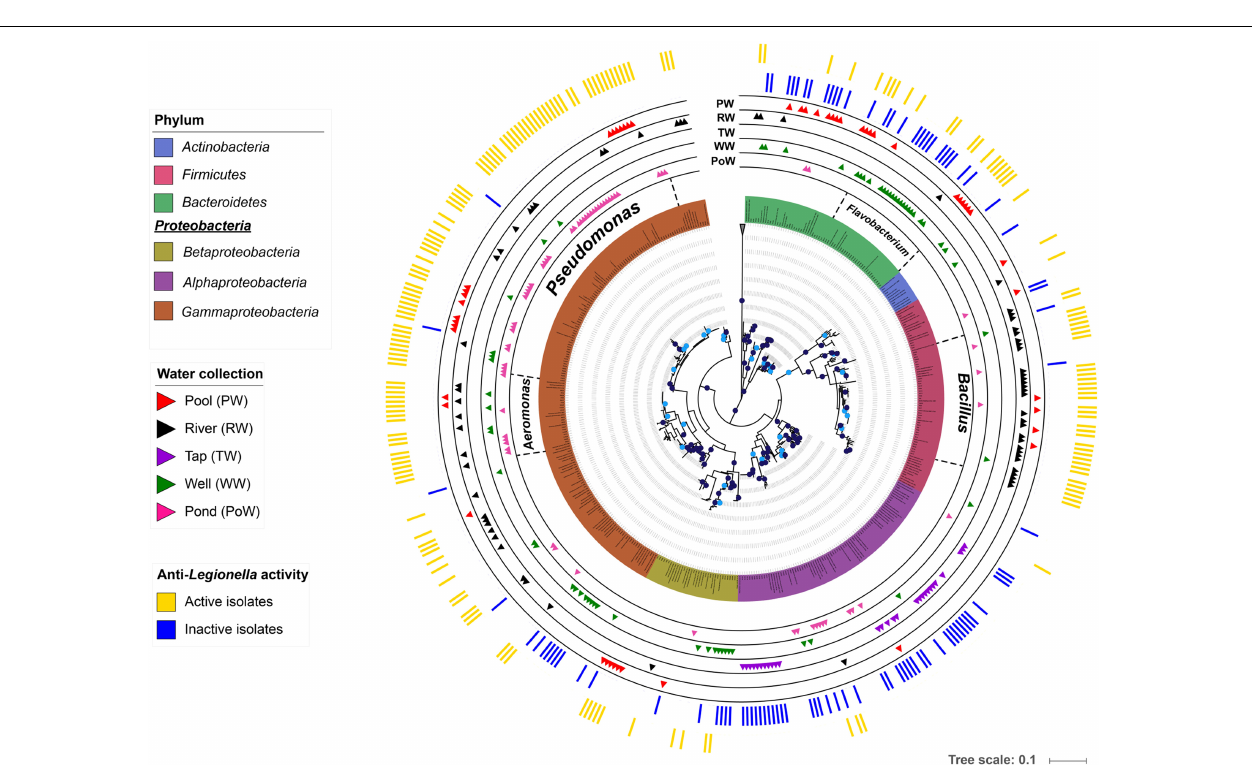
FIGURE 2 | Phylogenetic tree of anti- Legionella -associated environmental bacteria. The phylogenetic analysis was performed using the maximum likelihood phylogenetic method on MEGA v7 and the tree was viewed with iTOL (Letunic and Bork, 2016). Branches with bootstrap values (1000 replicates) higher than 70% are marked with dark blue dots, and those between 60 and 70% with light blue dots (The tree did not have branches with bootstrap value less than 60%). Environmental bacterial strains are color-coded by phyla, except for the Alphaproteobacteria, Betaproteobacteria, and Gammaproteobacteria which are depicted at the class level. The outer colored bands show the anti- Legionella profile with active isolates in yellow and inactive isolates in blue. The five internal bands show the distribution of each isolate among the five environmental water sub-collections (pond, pool, river, tap, and well).